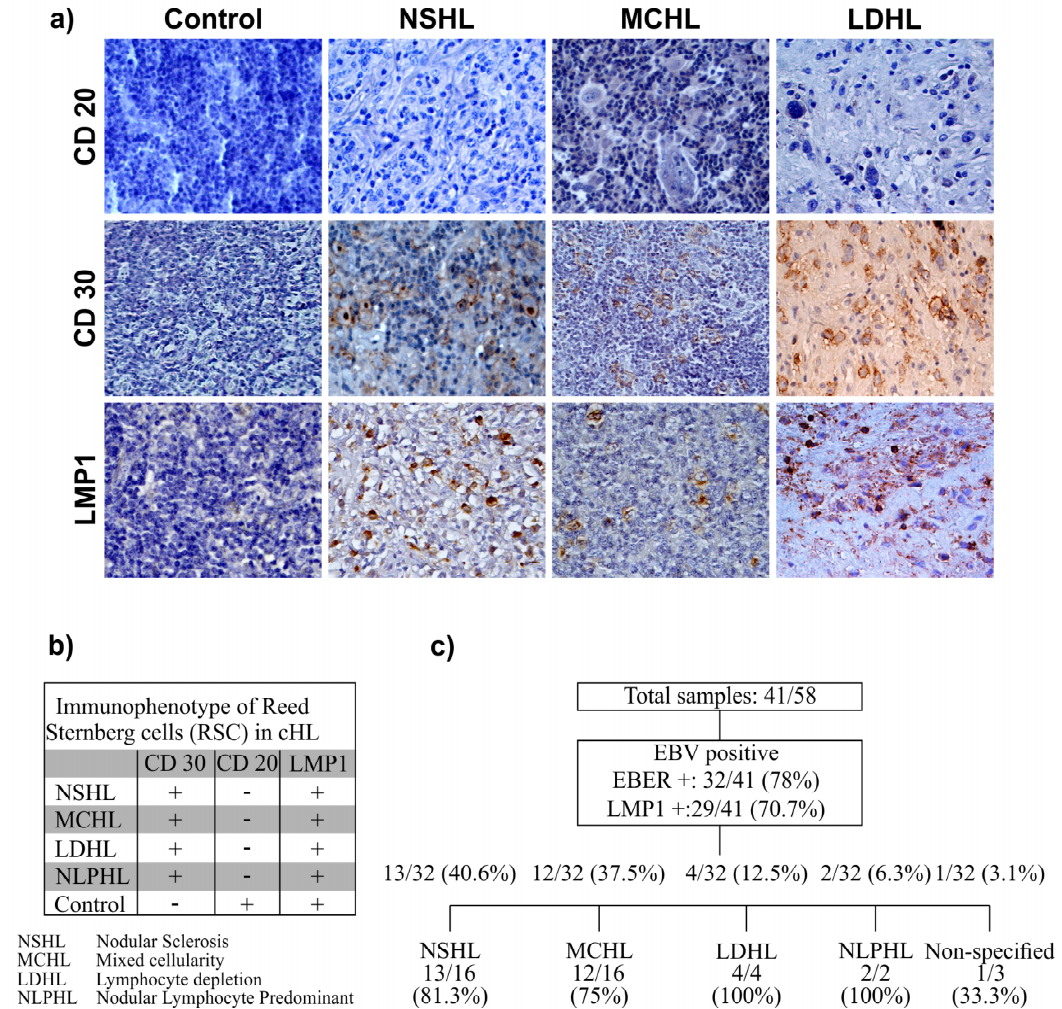
Figure 1. ( a ) Immunophenotype of Reed–Sternberg cells (RSC) in cHL, its different types, and positivity to LMP1 by immunohistochemistry (original magnification ×